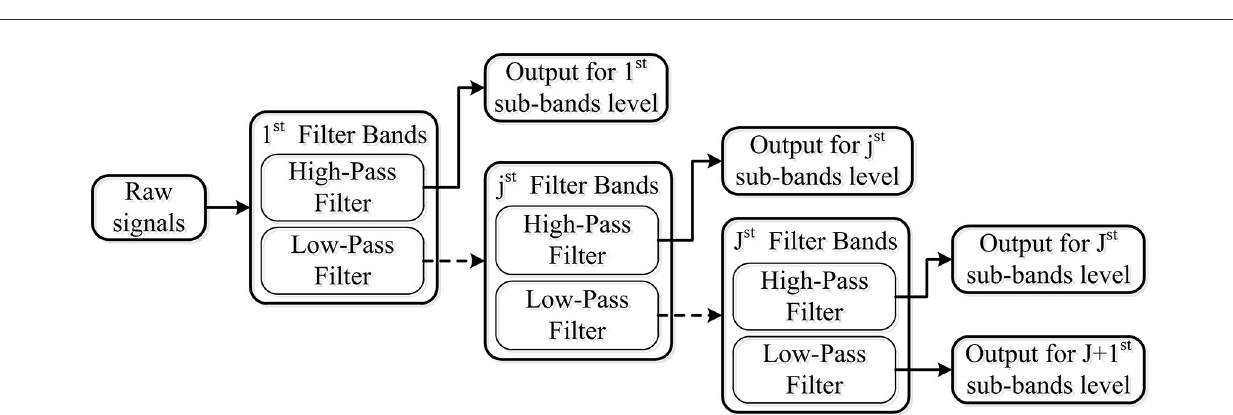
FIGURE3 Wavelet transform with J level using a two-channel filter bank, which consists of the low-pass filter and high-pass filter.